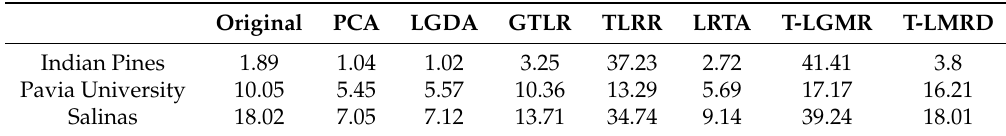
Table 4. Computational costs (in seconds) on three experimental